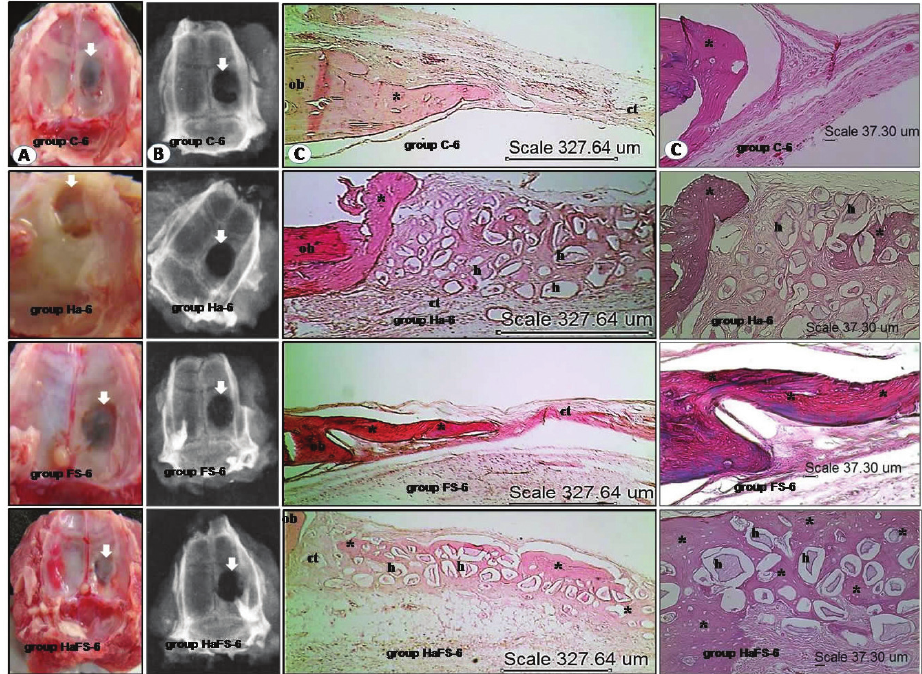
Figure 5. (A) Macroscopic, (B) radiologic and (C) histologic images obtained for animals of the four groups sacrificed 6 weeks (C-6, Ha-6, FS-6, HaFS-6) after surgical creation of a parietal bone defect. Note the absence of inflammatory signs. Microscopically, new bone was formed ( * ) from the borders of the original bone (ob) in all groups. This bone formation was more pronounced in group HaFS-2 in which most hydroxyapatite particles (h) were surrounded by new bone without connective tissue (ct)